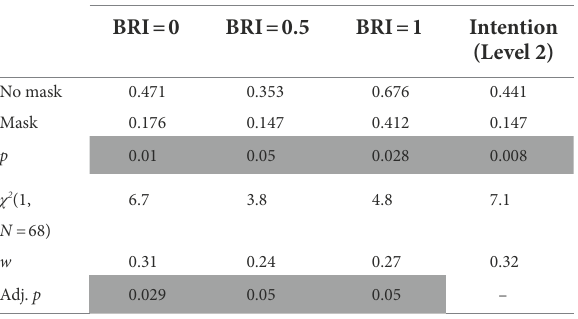
TABLE 6 Overlap of accumulated micro-activities (Level 3) with body reference index (BRI) and intention (Level 2) across conditions. Four micro-activities (PF-A/B, RO-A/B)